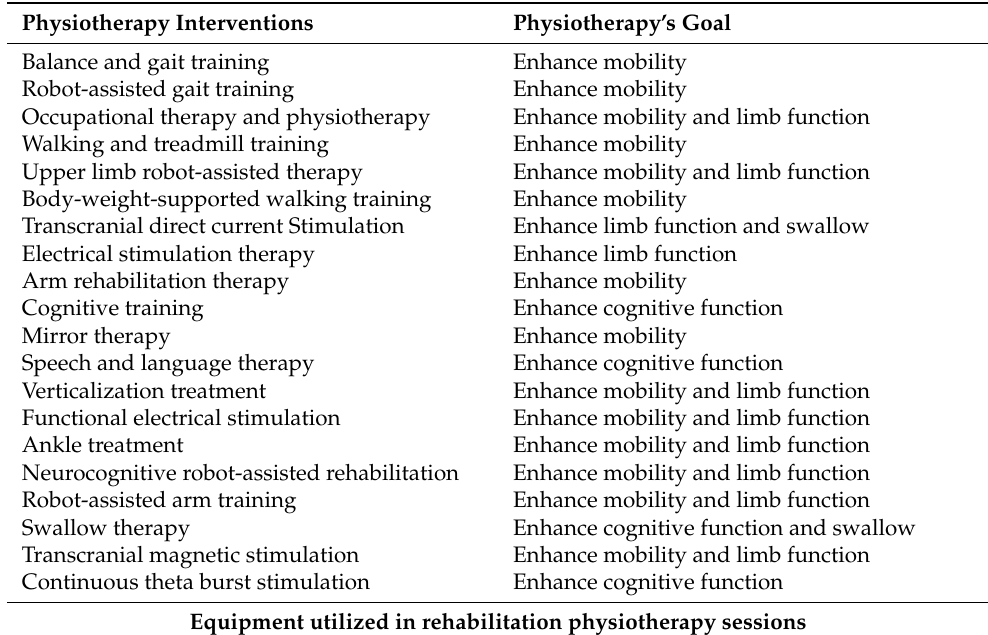
Table 1. Physiotherapy interventions for stroke and equipment utilized through clinical